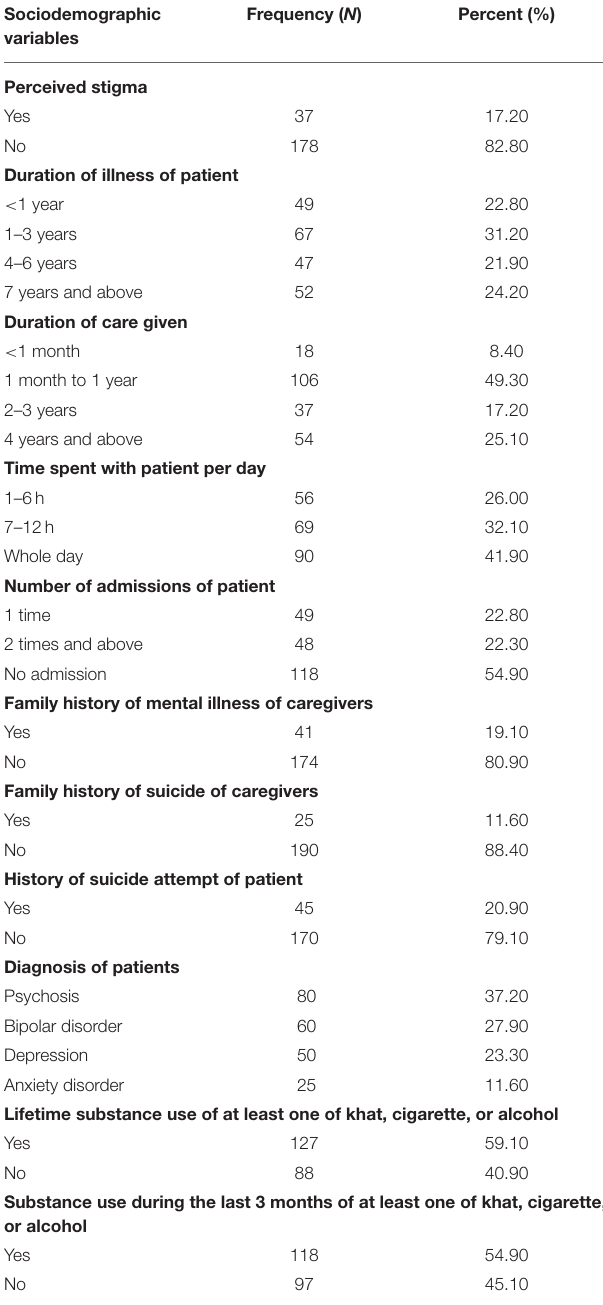
TABLE 2 | Clinical and substance use-related characteristics of primary informal caregivers of adults with mental illness at the HFSUH ( n = 215), Ethiopia, 2020. Sociodemographic